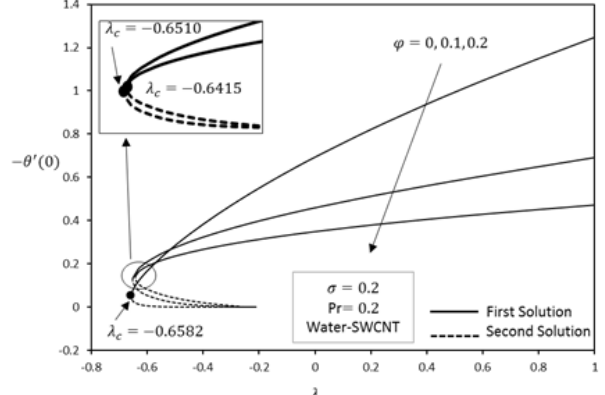
Figure 3. Effect of ϕ on reduced heat transfer ( ) 0 θ′− .